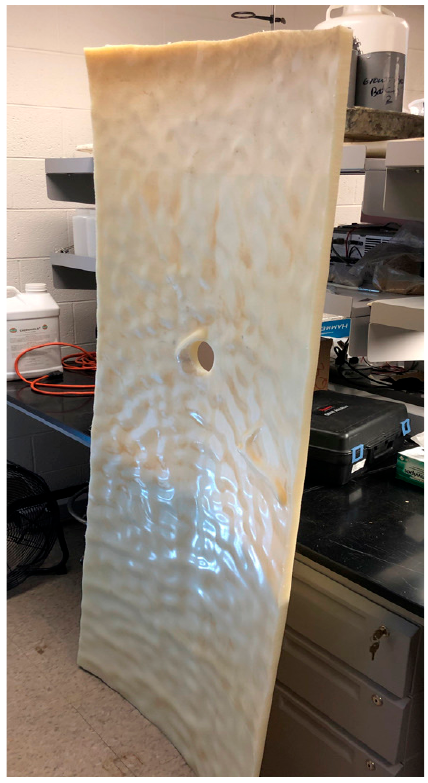
Figure 19. The waviness of the interior wall of an HDPE AST.